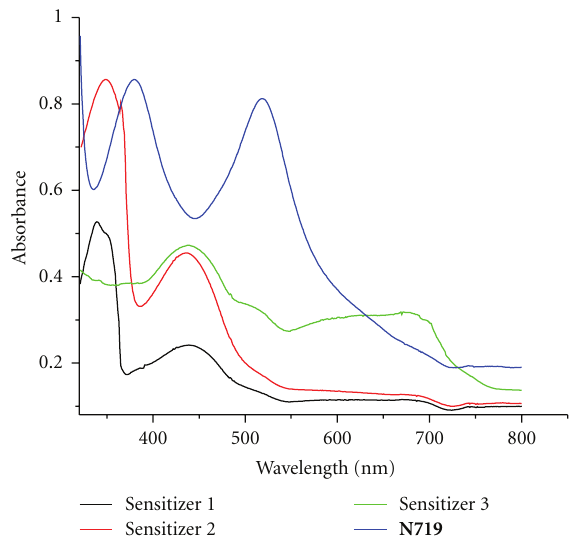
Figure 2: Absorption spectra of dyes 1, 2, and 3 in (C 2 H 5 OH = 1 × 10 − 5